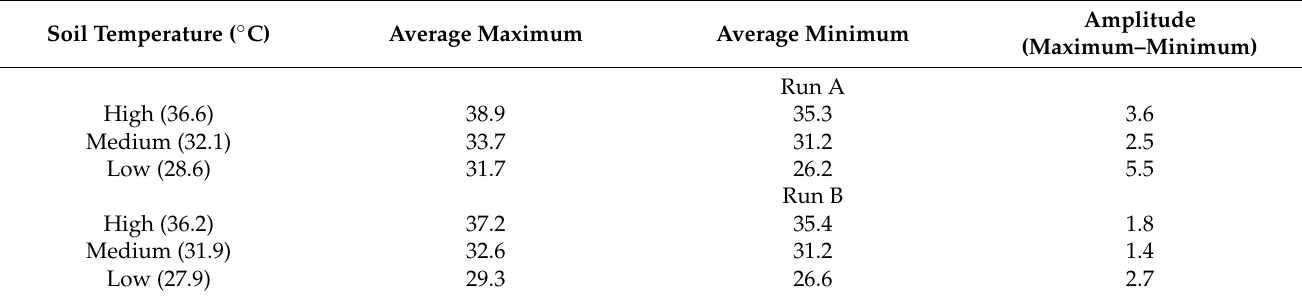
Table 3. Average daily maximum, minimum, and amplitude 5 cm soil temperature for soil tempera- ture treatments averaging 36.6 ◦ C, 32.1 ◦ C, and 28.6 ◦ C in run A and 36.2 ◦ C, 31.9 ◦ C, and 27.9 ◦ C in run B. Experimental runs were conducted in glasshouses in Knoxville, TN in